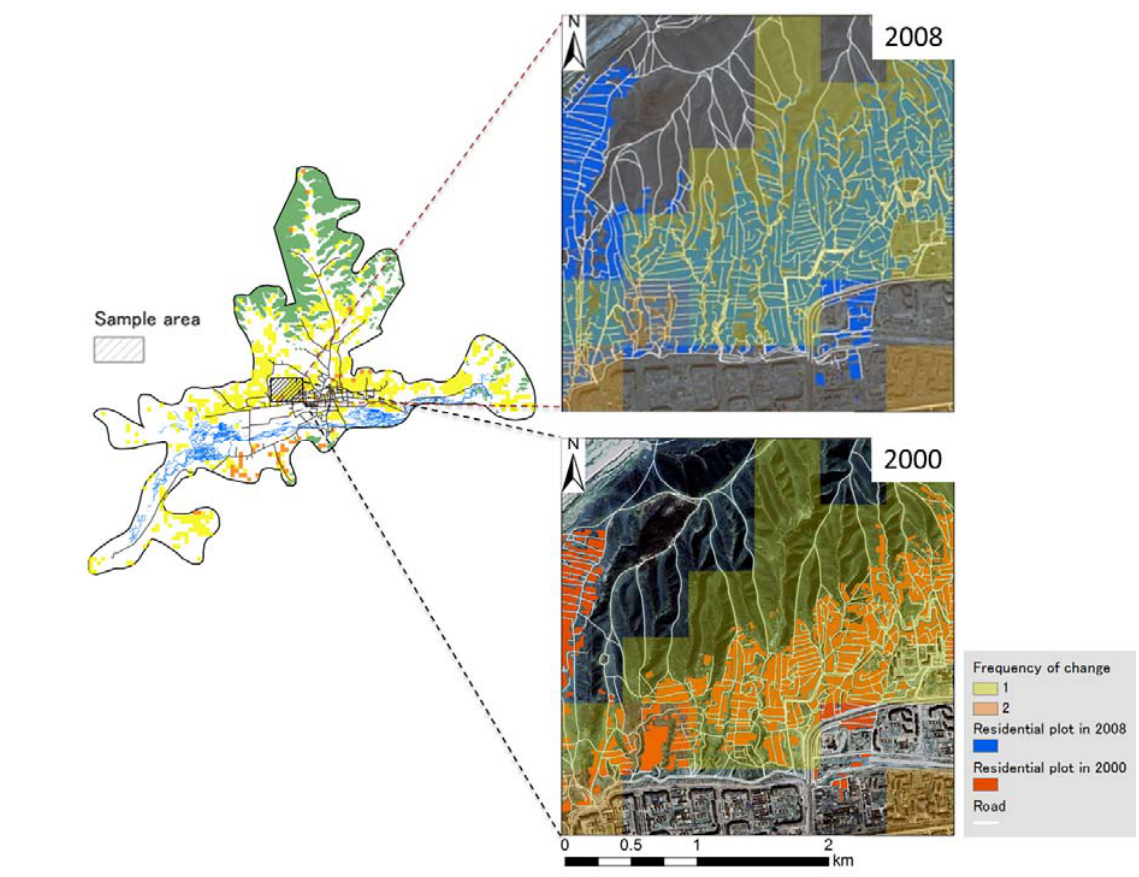
Figure 6. Spatial distribution of detected changes in the sample area and the expansion of the ger-area observed by bi-temporal images in 2000 and